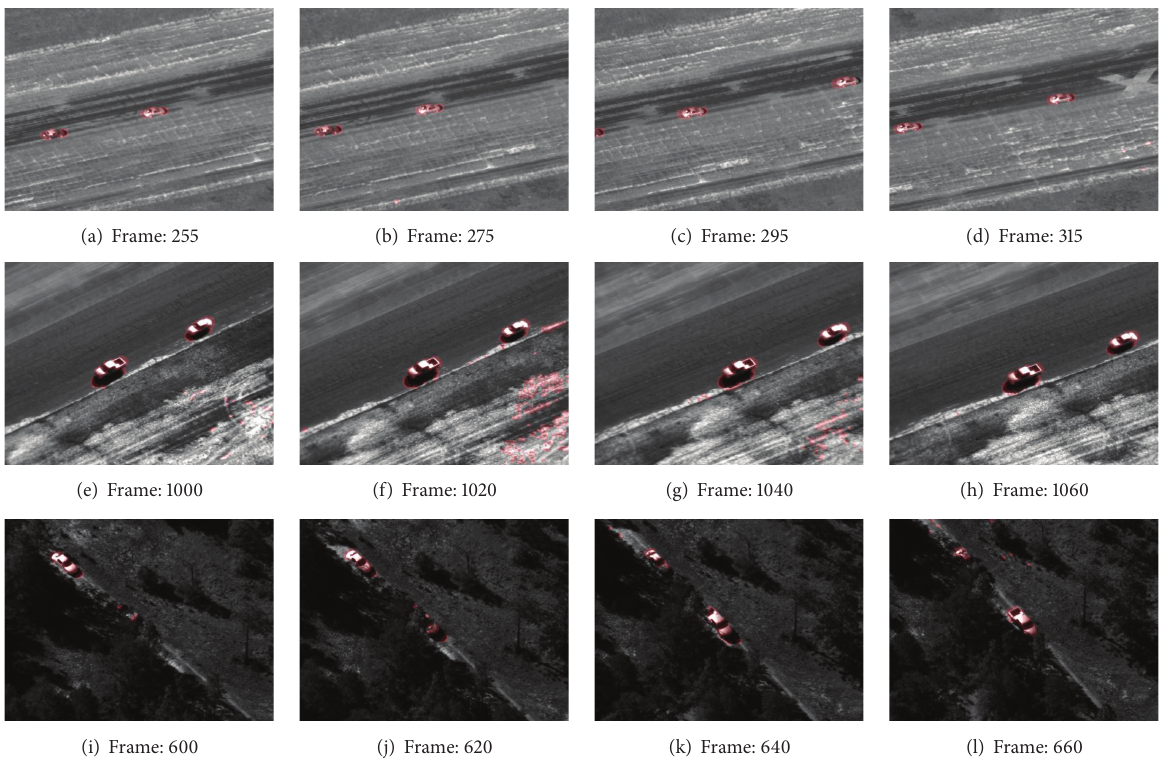
Figure 11: Detected regions from the proposed moving target detection SoC on different sample videos in [41]. Video numbers (a)–(d): V3V100003 004, video numbers (e)–(h): V3V100004 003, and video numbers (i)–(l): V4V100007 017.